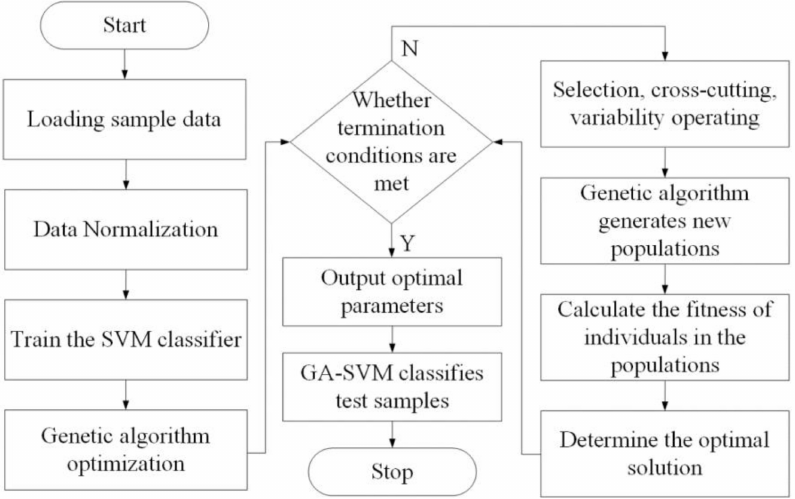
Figure 1. Genetic-algorithm-optimized support vector machine water-saving level classification